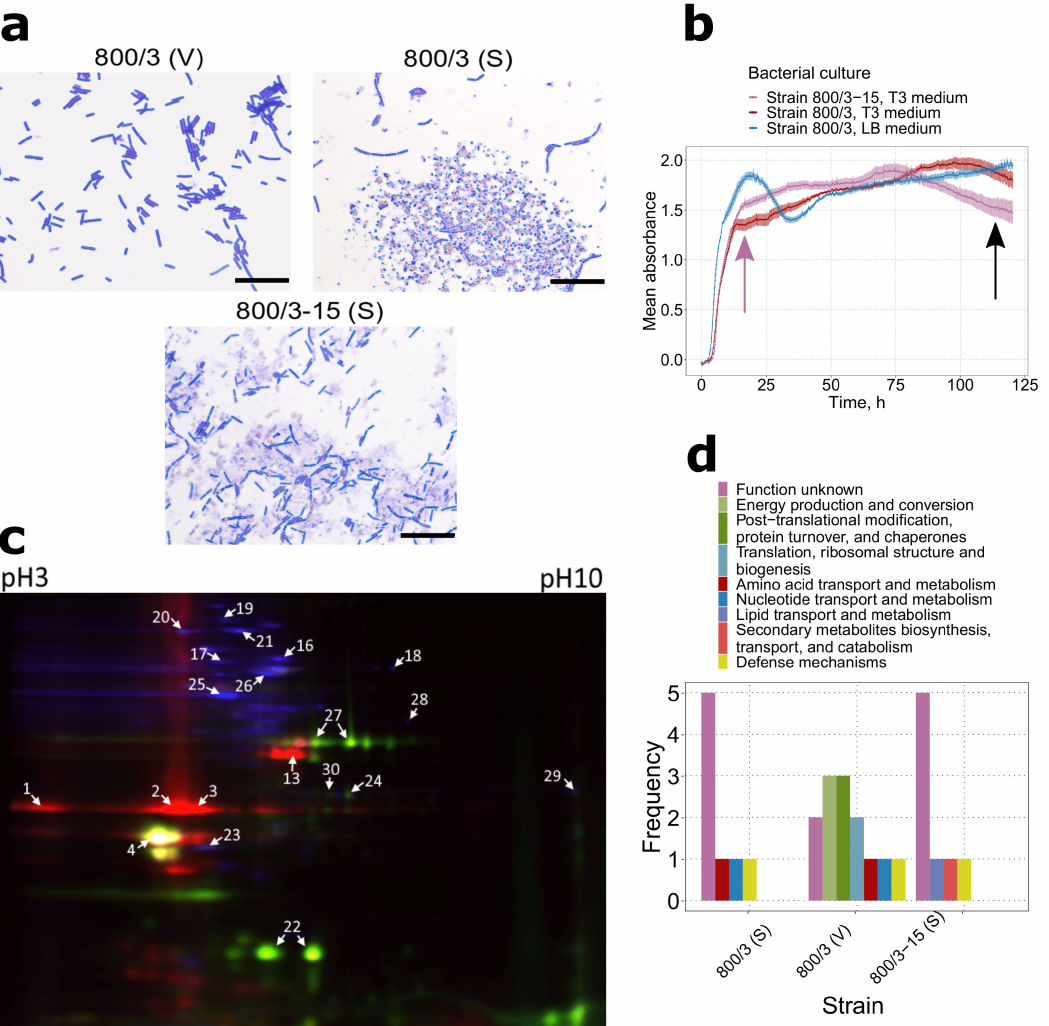
Figure 1. Proteomic signatures associated with different stages of the lifecycle in two strains belonging to serovar israelensis . ( a ) Microscope images of strain 800/3 vegetative culture (V), strain 800/3 virulent sporulating (S) culture, and strain 800/3-15 avirulent sporulating (A) culture All photos were taken at × 1000 magnitude in transmitted light. Scale bars are given as black rectangles and denote 20 µ m. Parasporal inclusions in the strain 800/3 spores were stained with Coomassie Blue. ( b ) Growth curves of strain 800/3 and 800/3-15 cultures grown on T3 medium and strain 800/3 vegetative cultures grown on LB solution medium. The purple arrow marks the time of the vegetative culture’s protein extraction, the black arrow—spore cultures ( c ) 2D-DIGE image corresponding to the overlapping Cy2, Cy3, and Cy5 fluorochrome channels of serovar israelensis proteomes. Red light channel indicates– proteins from strain 800/3, blue—strain 800/3 vegetative cells proteins, and green—strain 800/3-15 spore proteins. ( d ) The COG term distribution among the proteins detected with ESI-MS. COG annotation was assigned to the reference sequences by sequence homology using eggNOG